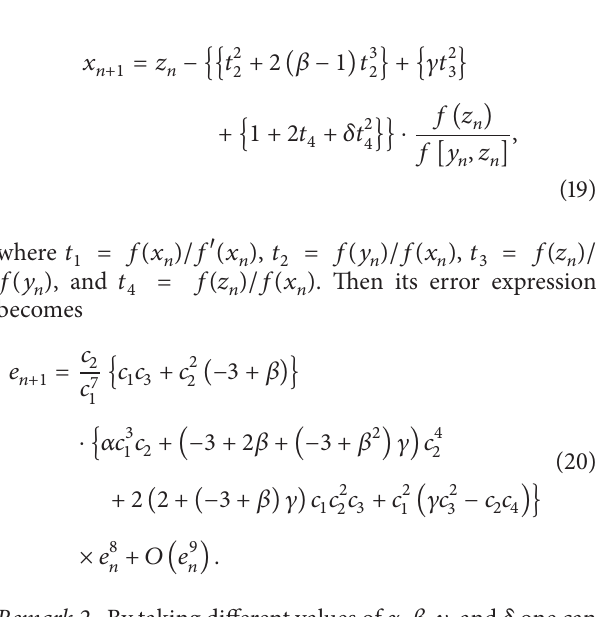
Figure 3: Basins of attraction for non-polynomial 𝑃 3 (𝑧) = (𝑧 3 − 1/2𝑧 + 1)